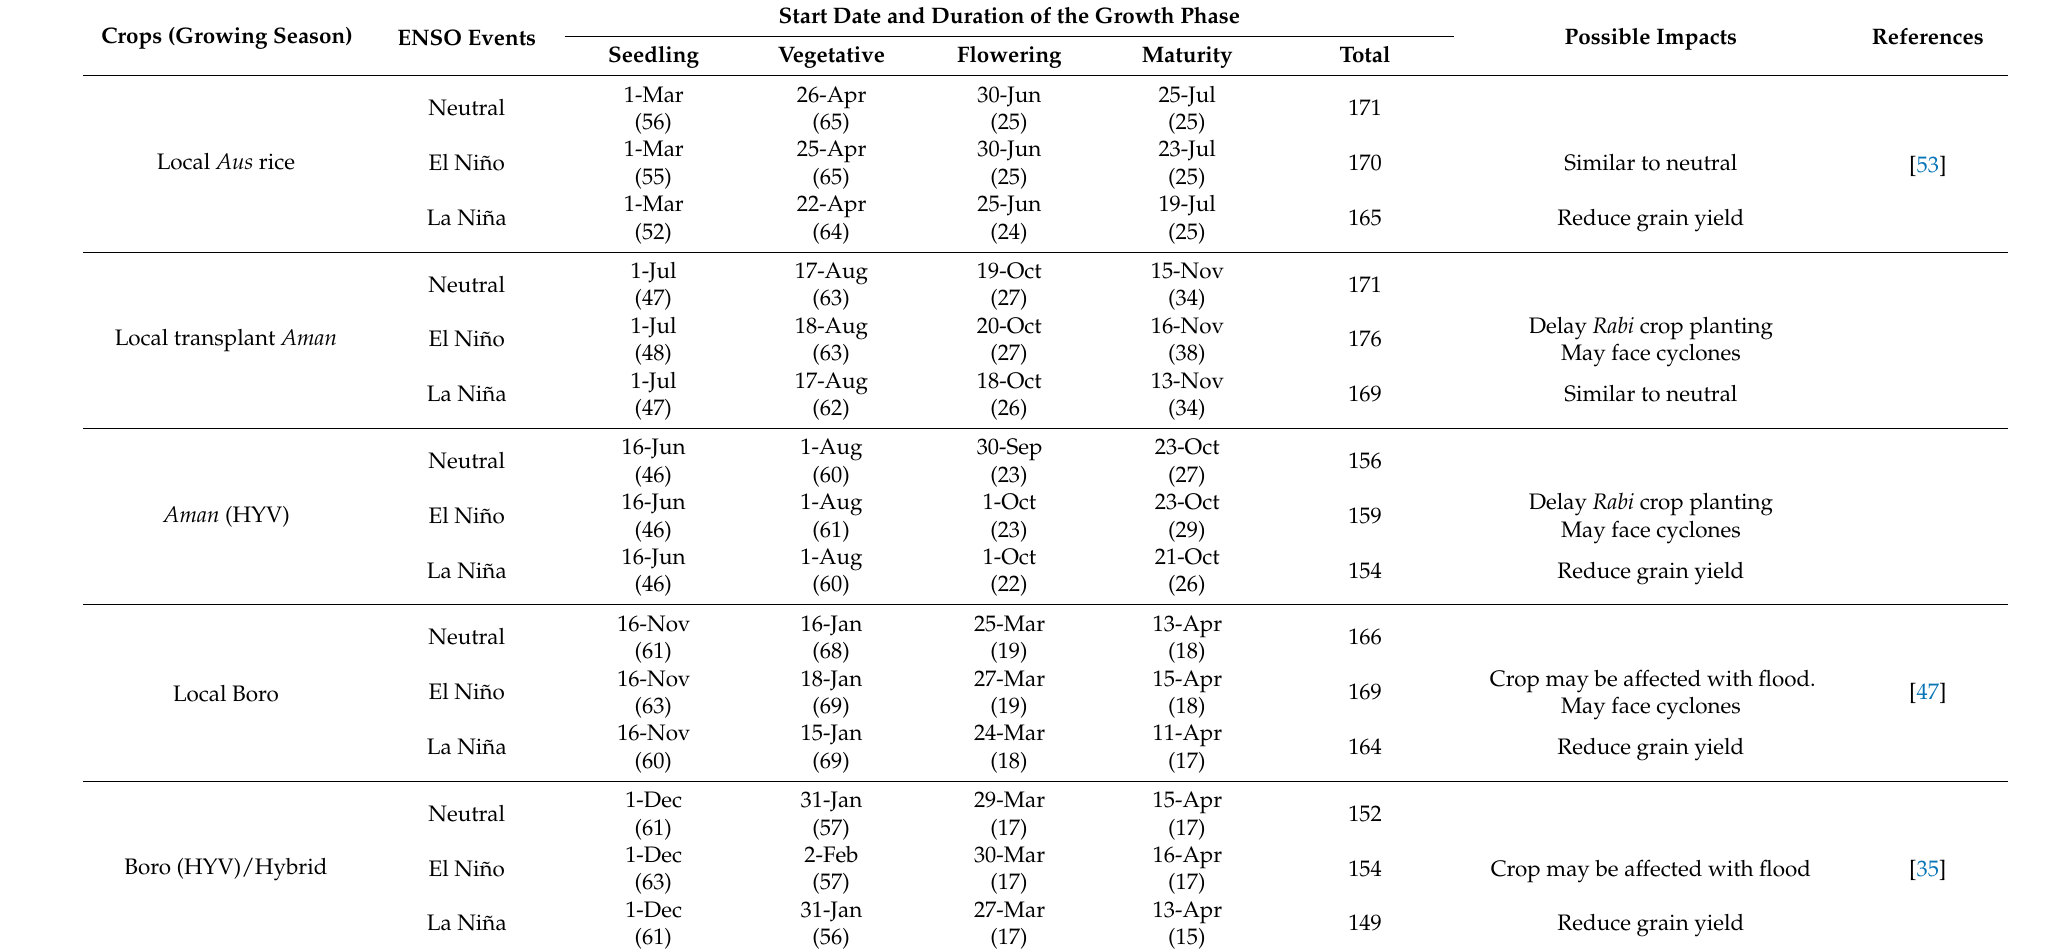
Table 2. Impacts of ENSO events on crops grown in